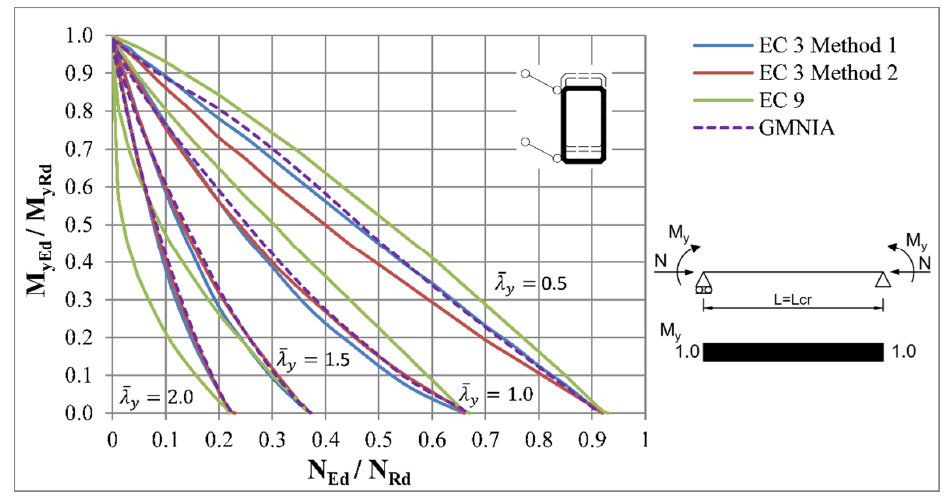
Figure 33. Interaction curves for laterally restrained beam-columns with RHS cross-section.